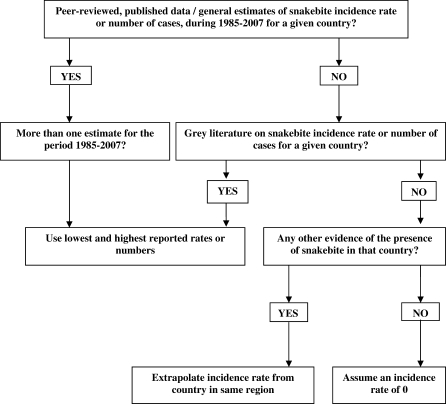
Algorithm for Calculation of Morbidity Due to Snakebite